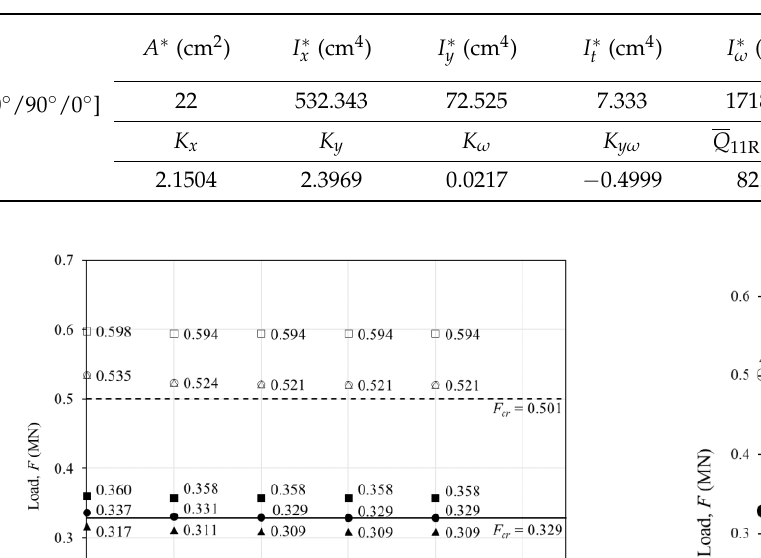
Table 1. Cross-section properties of Examples 1 and 3.